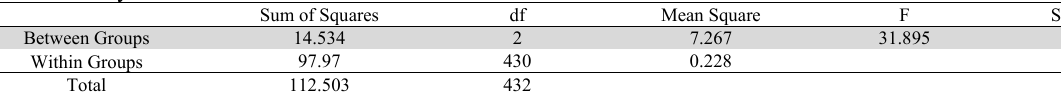
Results of Analysis of Variance for staff